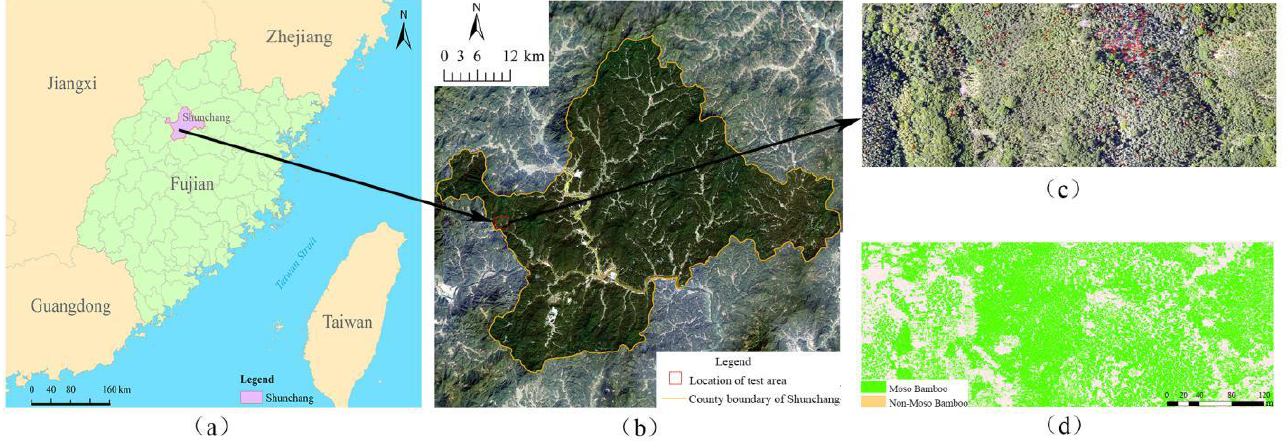
Figure 1. Overview of the test area and data processing: ( a ) geographic location of Shunchang County; ( b ) aerial image of Shunchang County; ( c ) unmanned aerial vehicle (UAV) orthophoto image of the test area; ( d ) image obtained after extracting the thematic information of Moso bamboo forest from UAV images.